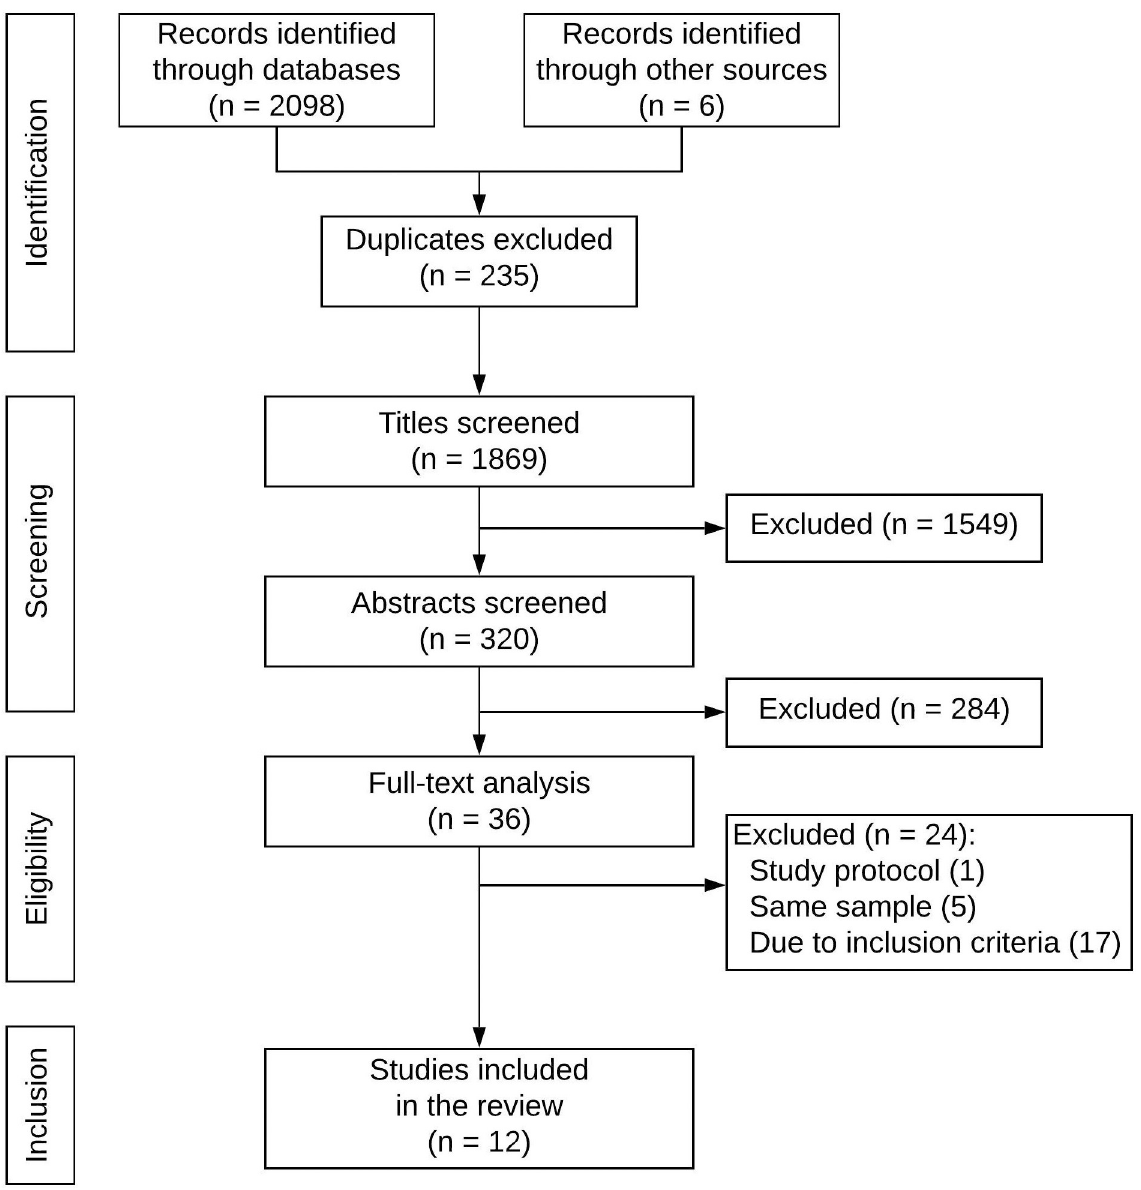
Fig 1. Flowchart: Study screening and